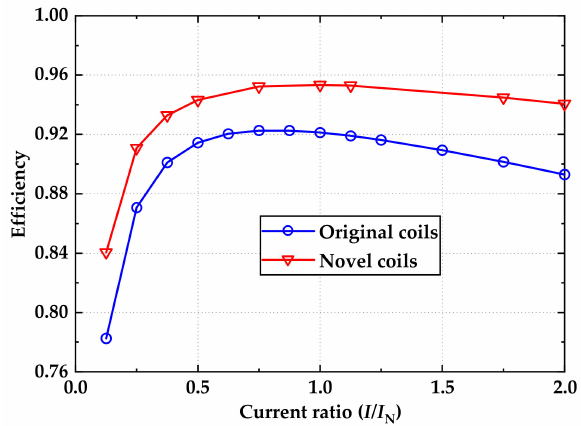
Figure 14. Efficiency variation with different